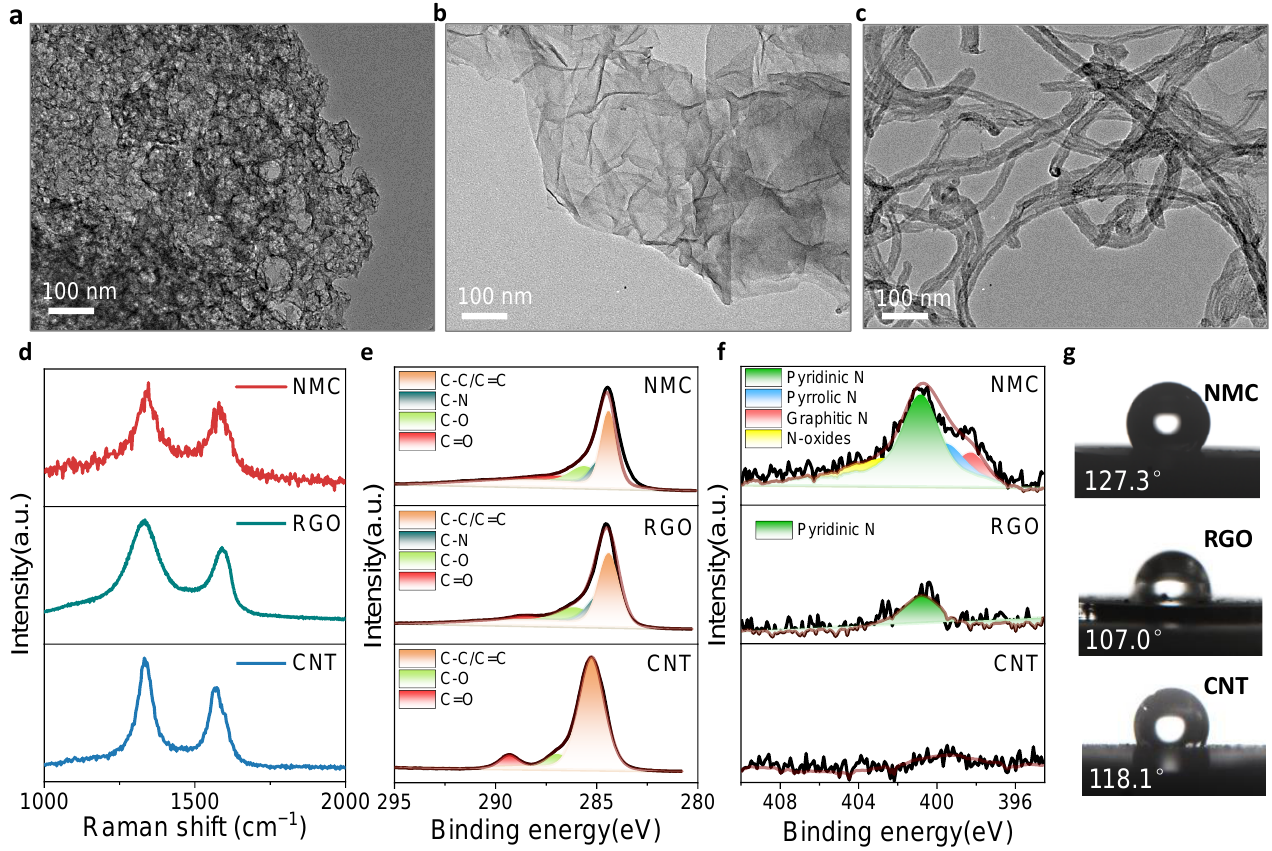
Figure 2. Structure comparison between NMC, RGO, CNT. ( a – c ) TEM images of NMC, RGO and CNT. ( d ) Raman spectra for NMC, RGO and CNT. (e-f) XPS spectra in the regions of ( e ) C 1s and ( f ) N 1s spectra for NMC, RGO and CNT. ( g ) Contact angles for NMC, RGO and CNT.